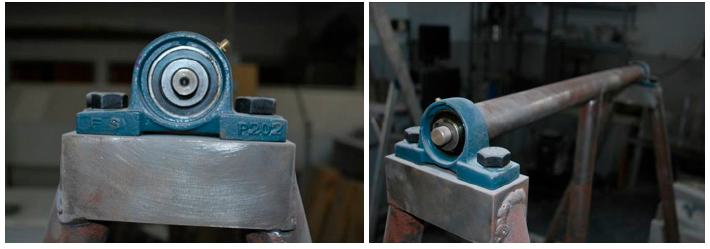
Figure 6. Shaft of rotation.